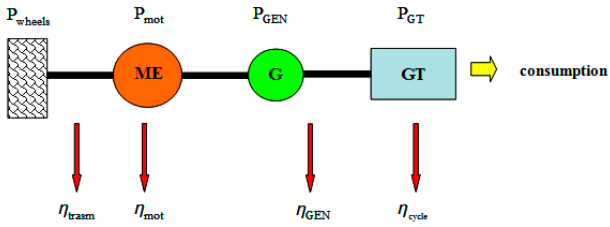
Figure 10. Power Flows Through the Components.